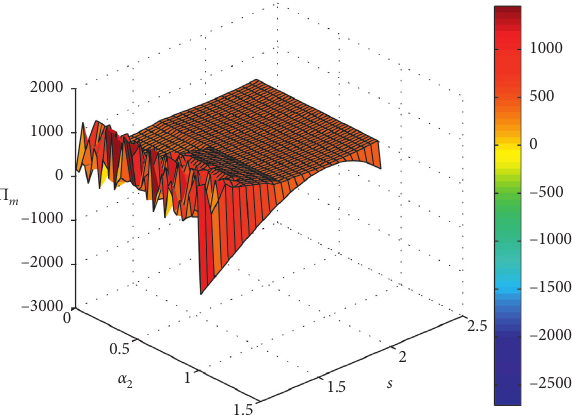
Figure 19: 3D profit diagram for the manufacturer with α